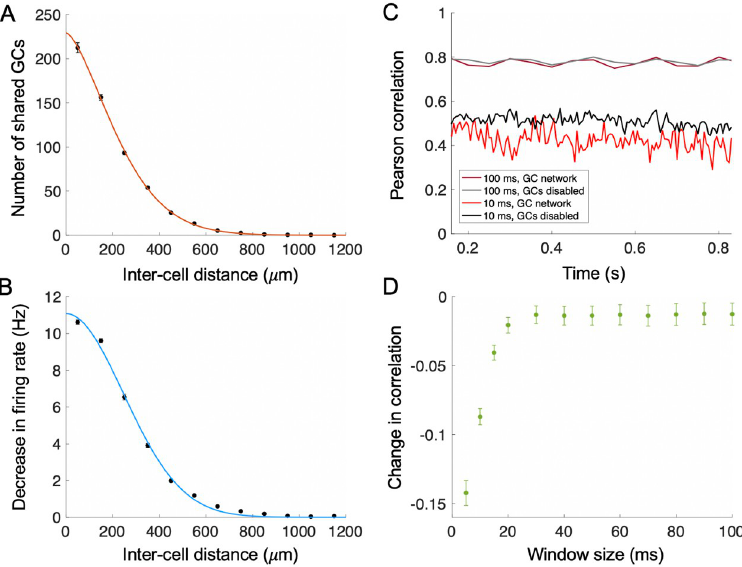
Fig 5. Network connectivity, lateral inhibition, and decorrelation. (A) The number of shared GCs between pairs of MCs ( n = 1436). MC pairs were partitioned based on inter-cell distance into 12 bins each representing a 100 μ m span. Each point represents the average number of shared GCs of all MC pairs in a given bin and was placed halfway along the bin width, with the bar representing standard error. The red curve is a fit of the form a exp( − bx n ), with x in microns, a = 229.2, b = 1.721e- 04 and n = 1.545. (B) Lateral inhibition strength decreases with distance between MCs. MC pairs ( n = 1436) were simulated with one and then both cells receiving current input, and the resulting decrease in firing rate for the first cell was measured. MC pairs were again partitioned based on inter-cell distance into 12 bins each representing a 100 μ m span. Each point represents the average decrease in firing rate of all MC pairs in a given bin and was placed halfway along the bin width, with the bar representing standard error. The blue curve represents a fit of the form a exp( − bx n ), with a = 11.08, b = 9.375e- 06 and n = 1.976. (C) Example of evolution of Pearson correlation between model OB responses to two odors, each targeting 30 of 178 glomeruli (25 overlapping) over time, in the presence and absence of GC activity. Dark red/grey: GCs enabled/disabled for 100 ms time window. Bright red/ black: GCs enabled/disabled for 10 ms time window. (D) The decrease in Pearson correlation was maximal for shorter timescales. We measured mean correlation over the period after the first sniff ( 1 of a second) for networks with and 6 without GCs, and then calculated the difference of the two. The magnitude of decorrelation increased as the window size decreased below 20 ms. Data averaged over n = 15 odor pairs, each odor activating 30 glomeruli, and with varying overlap ranging from 5 to 25 glomeruli (average overlap = 18). Error bars = standard error of the mean.